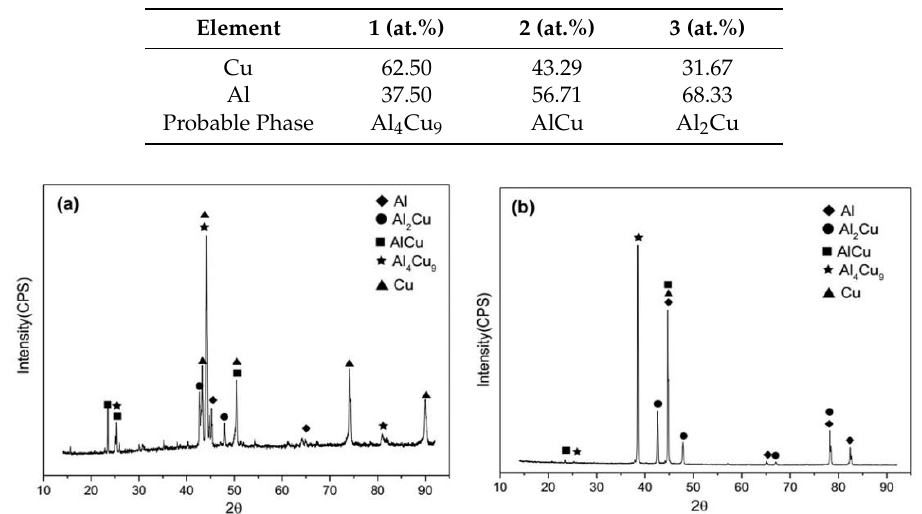
Table 2. The EDS results of the BSE image in Figure 3.